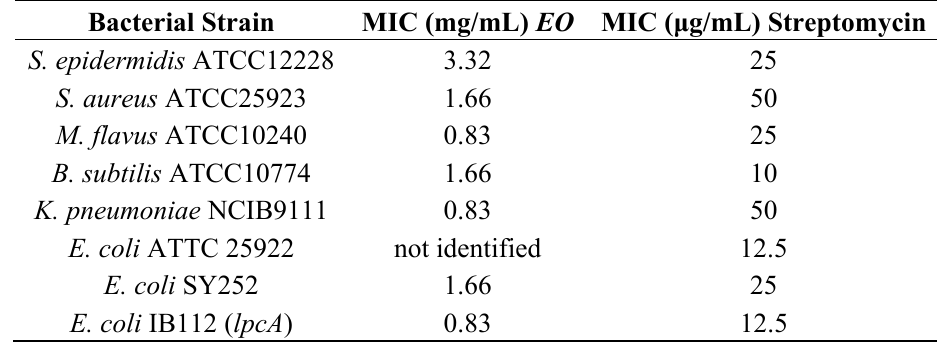
Table 5. MIC values of essential oil ( EO ) of E. gunnii and streptomycin as reference